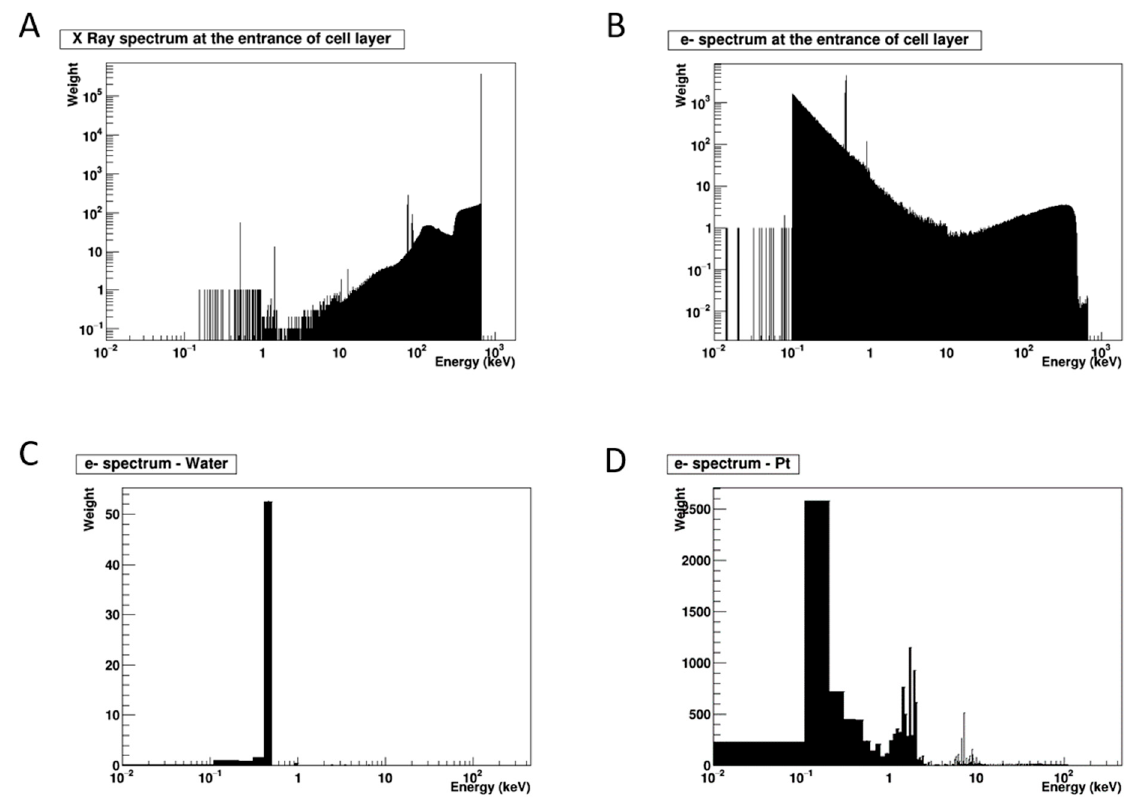
Figure 7. Simulation of the energy spectra at the entrance of the cell layer and released by the nanoparticles. ( A ) Energy spectra of X-rays entering the cell culture. ( B ) Energy spectra of electrons entering the cell culture. ( C ) Energy spectra of the electrons produced in a nanoparticle made of liquid water and Pt ( D ) and escaping the nanoparticle.